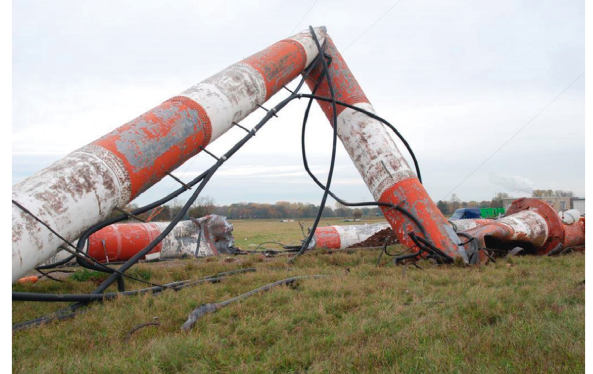
Figure 8: Guyed mast debris section partly penetrated into the